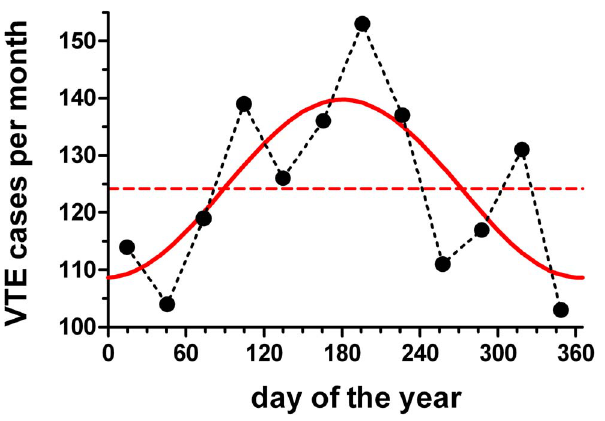
Figure 4. Periodic regression of venous thromboembolism (VTE) cases (Detroit). Black circles indicate the monthly averages. The periodic regression is shown in red ( P =0.028; R 2 =0.55); June 30 th peak. Periodic mean=124.2 cases/month (dashed red line).